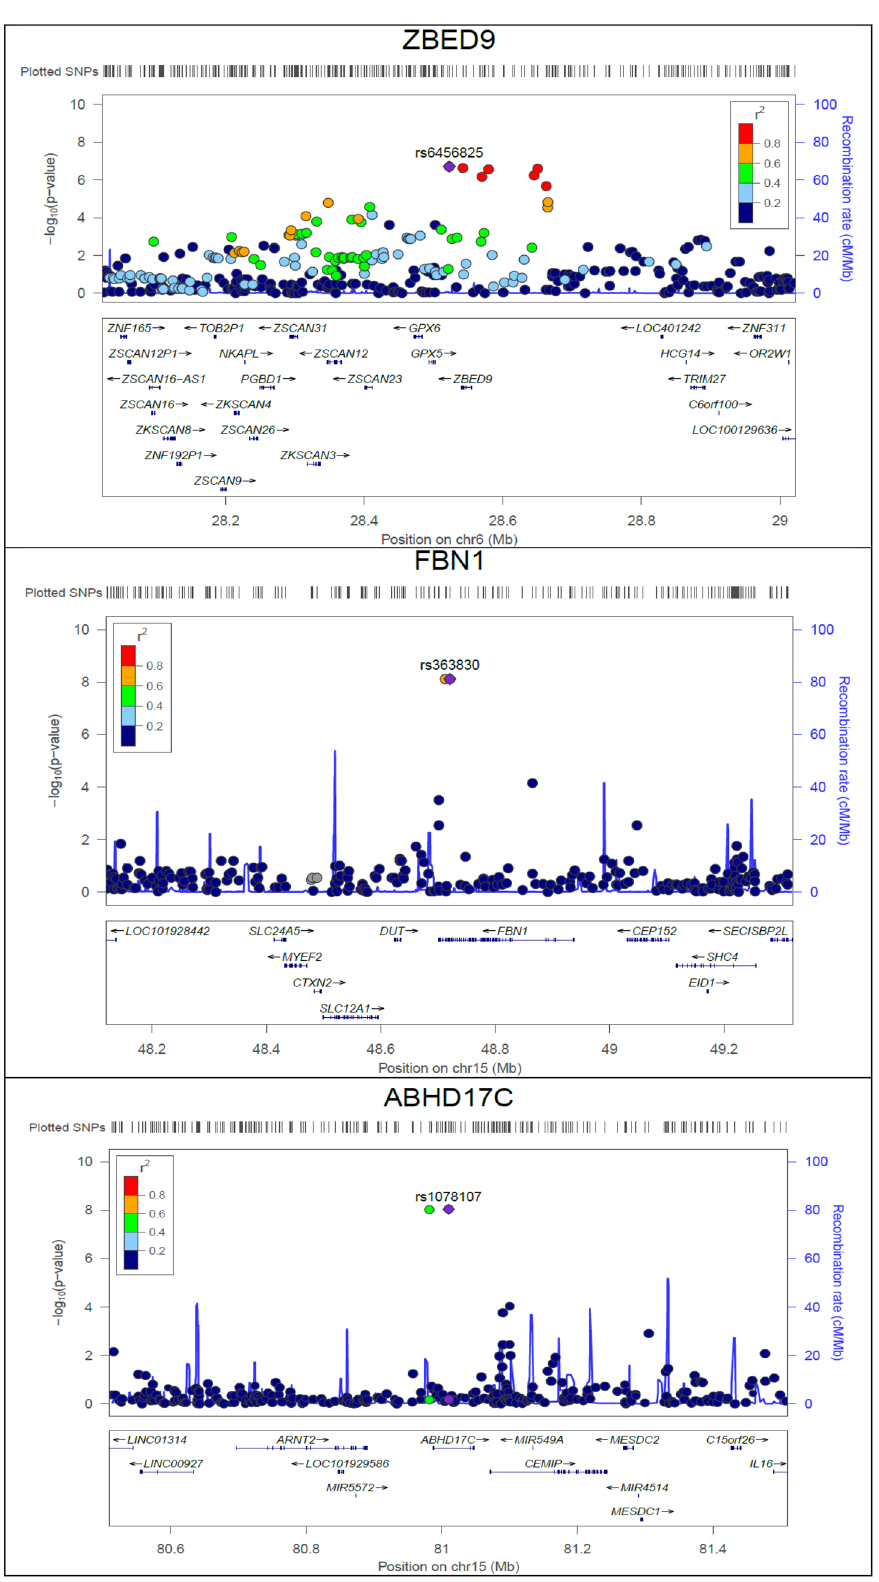
Figure 5. Locus zoom plot of GWAS findings in detected